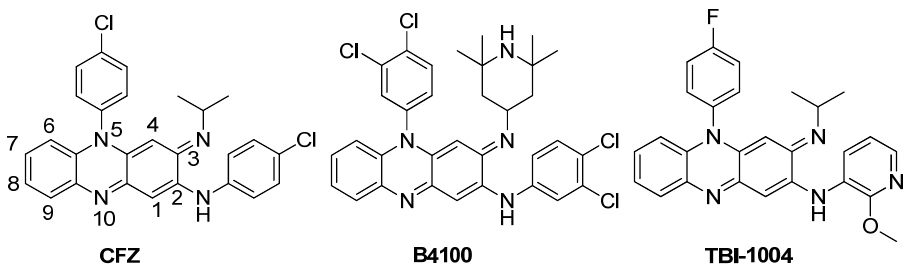
Figure 1. Structures of CFZ and its